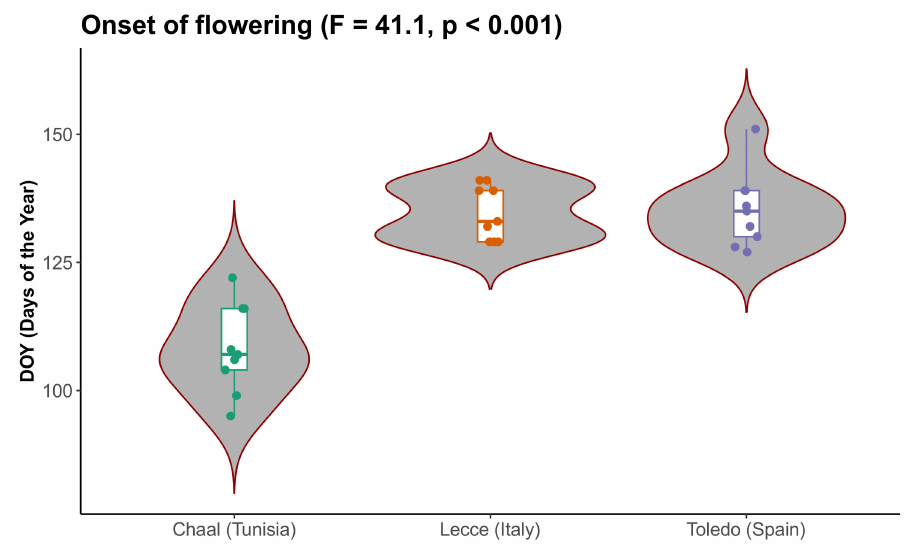
Figure 3. Dispersion of the data of the start date of flowering in days of the year (DOY) for each station in the common study period